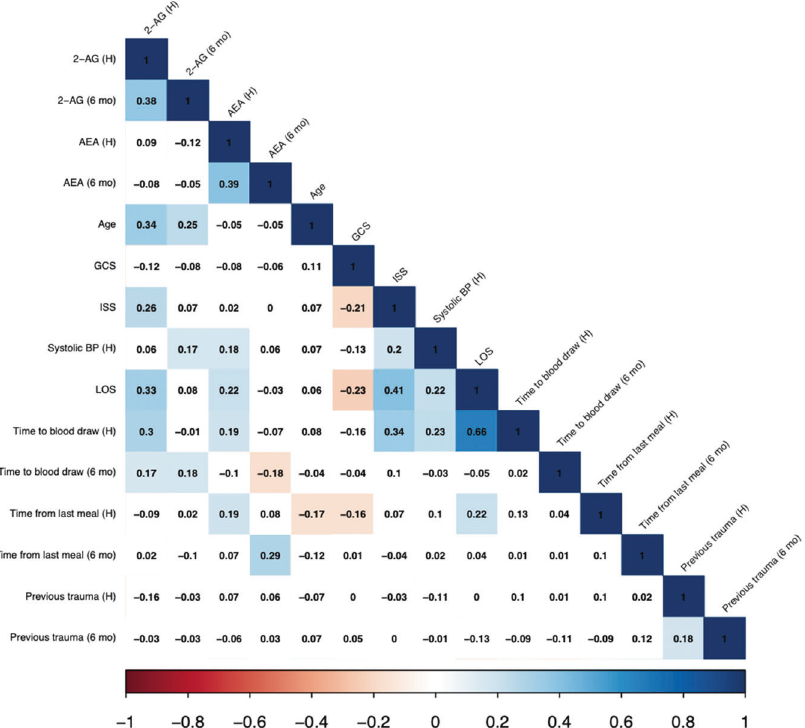
Fig. 2 Correlation matrix of serum endocannabinoid concentrations at both time points; and selected demographic and clinical characteristics. 2-AG = 2-arachidonoylglycerol; AEA = N -arachidonoylethanolamine; H = hospitalization; 6 mo = 6 – 8 months follow-up visit; GCS = Glasgow Coma Scale; ISS = injury severity score; BP = blood pressure; LOS = length of stay in the hospital. Time to blood draw refers to the number of days from trauma to blood draw in hospital (H) and follow-up (6 mo); time from last meal is hours from last time eating to a blood draw in the hospital (H) and at follow-up (6 mo). Previous trauma (H) is trauma history prior to injury; and Previous trauma (6 mo) is trauma history between injury to follow-up entire sample were analyzed. In the combined sample, AEA concentrations at follow-up were positively correlated with total PCL5 ( p = 0.046) and the arousal subscore ( p = 0.017) both at hospitalization, as were AEA concentrations and PCL5 avoidance subscores ( p = 0.032) both at follow-up. 2-AG concentrations at follow-up were signi fi cantly, negatively associated with avoidance subscores ( p = 0.047) at hospitalization.